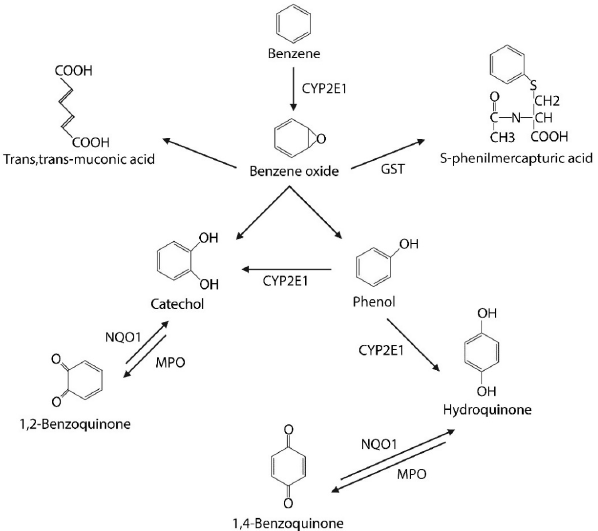
Figure 1. The principal steps of benzene metabolism, its products, and the involved